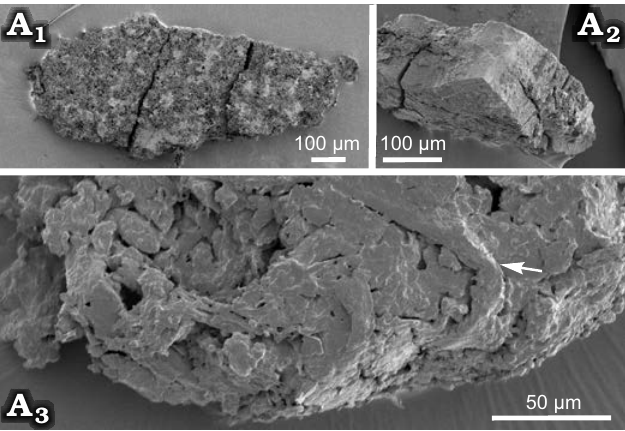
Fig. 3. SEM micrographs of sporangia and spores of Konijnenburgia cf. galleyi (Miner, 1935) Kvaček and Dašková, 2010; MB.Pb.2008/372, Żerkowice, North Sudetic Basin, Lower Silesia, Poland, Assemblage 4 (up - per Conia cian?–lower Santonian?). A . Complete sporangium (A 1 ), trans- verse section of a sporangium showing sporangial walls surrounding spores (A 2 ), sporangium fragment showing thickly cutinised cells of the annulus (arrow) (A 3